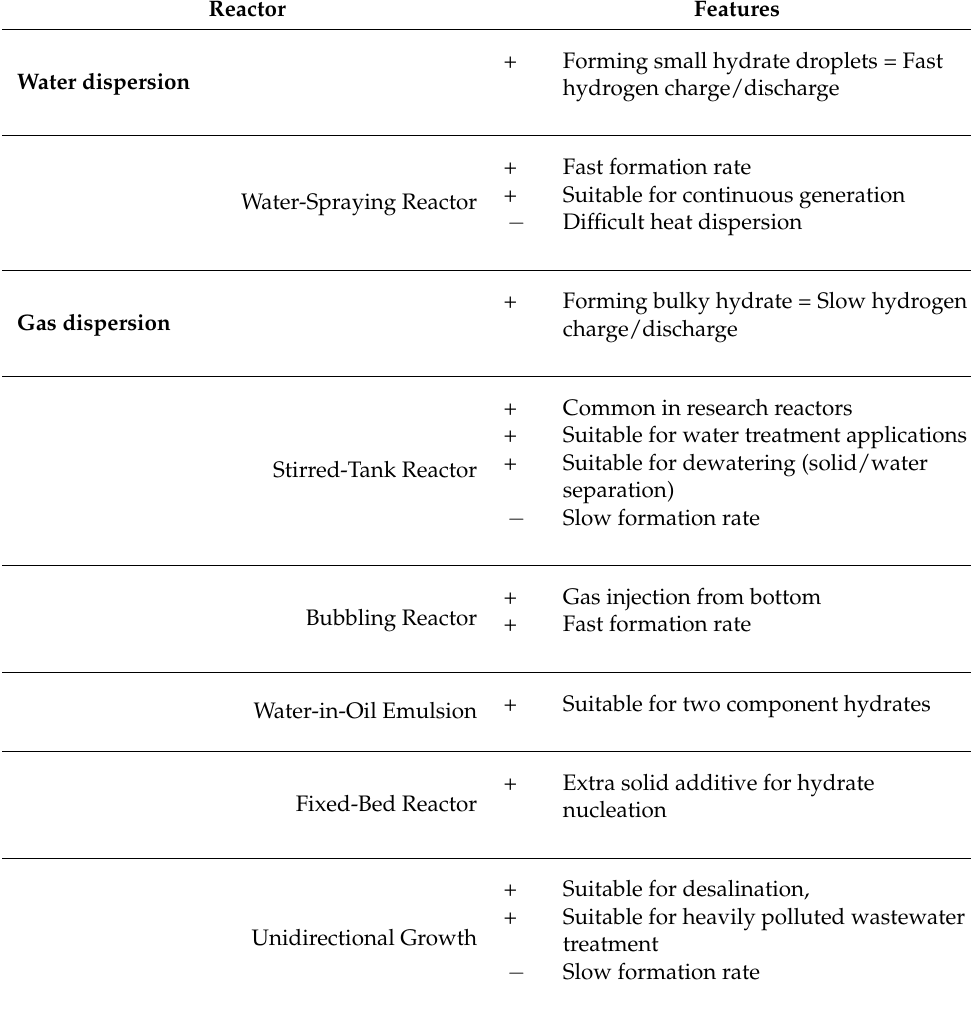
Table 1. Hydrate formation reactors, advantages and disadvantages. Reactor